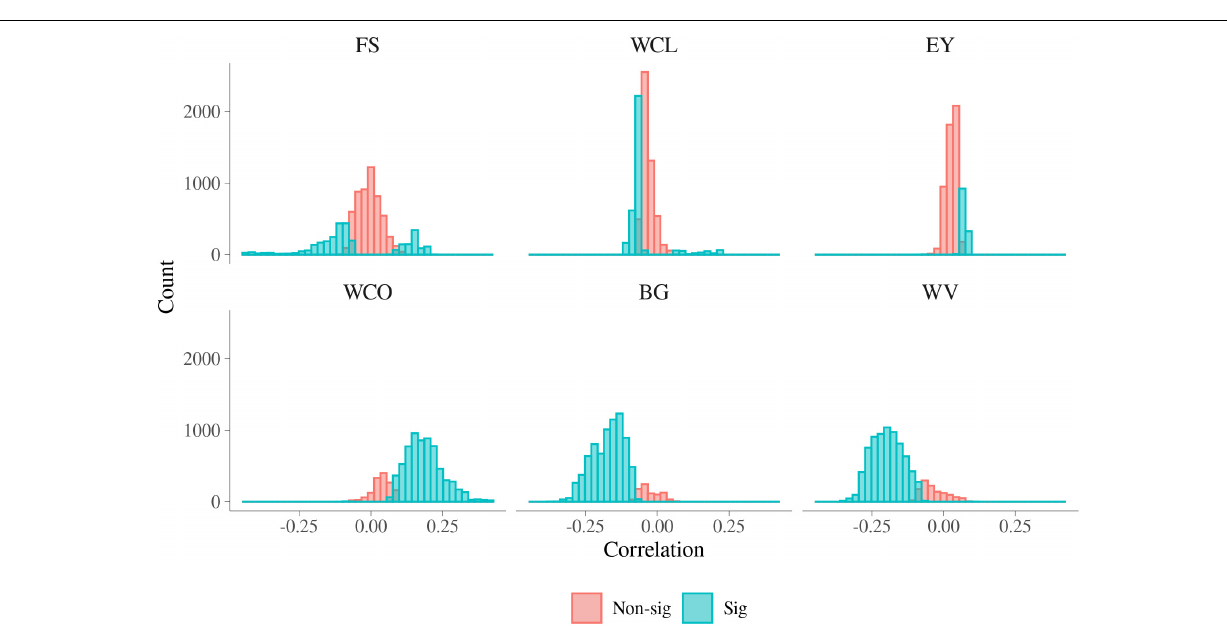
FIGURE 6 | Phenotypic correlations for malting traits with significant metabolomic features. FS, filtering speed; WCL, wort clearness; EY, extract yield; WCO, wort color; BG, beta glucan; WV, wort viscosity.